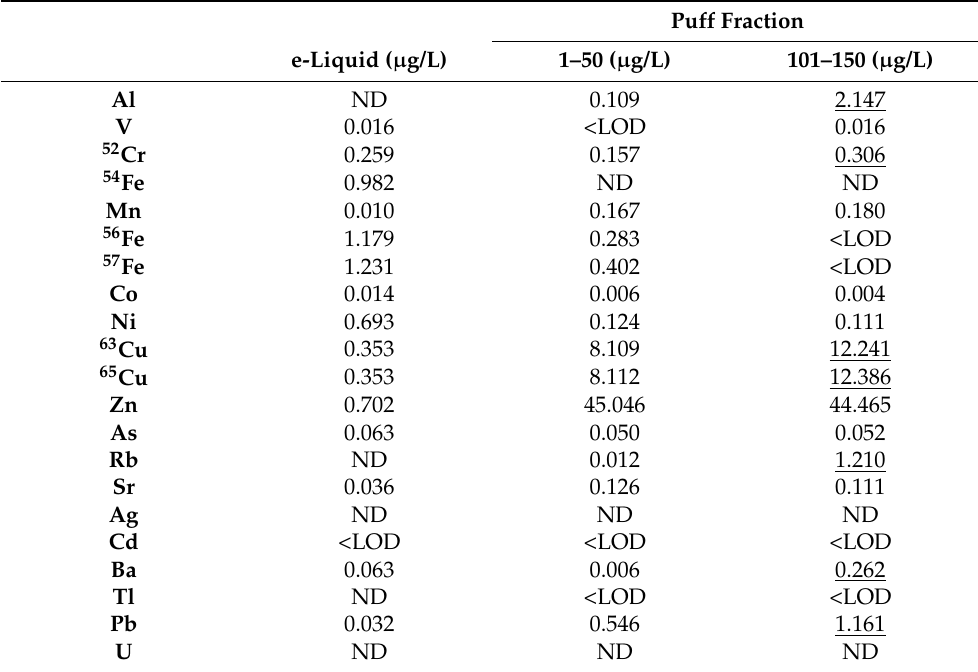
Table 3. Average amounts ( n = 2, σ < 1) of metals of concern to human health in tobacco-flavored e-liquid and resulting ENDS aerosol puff